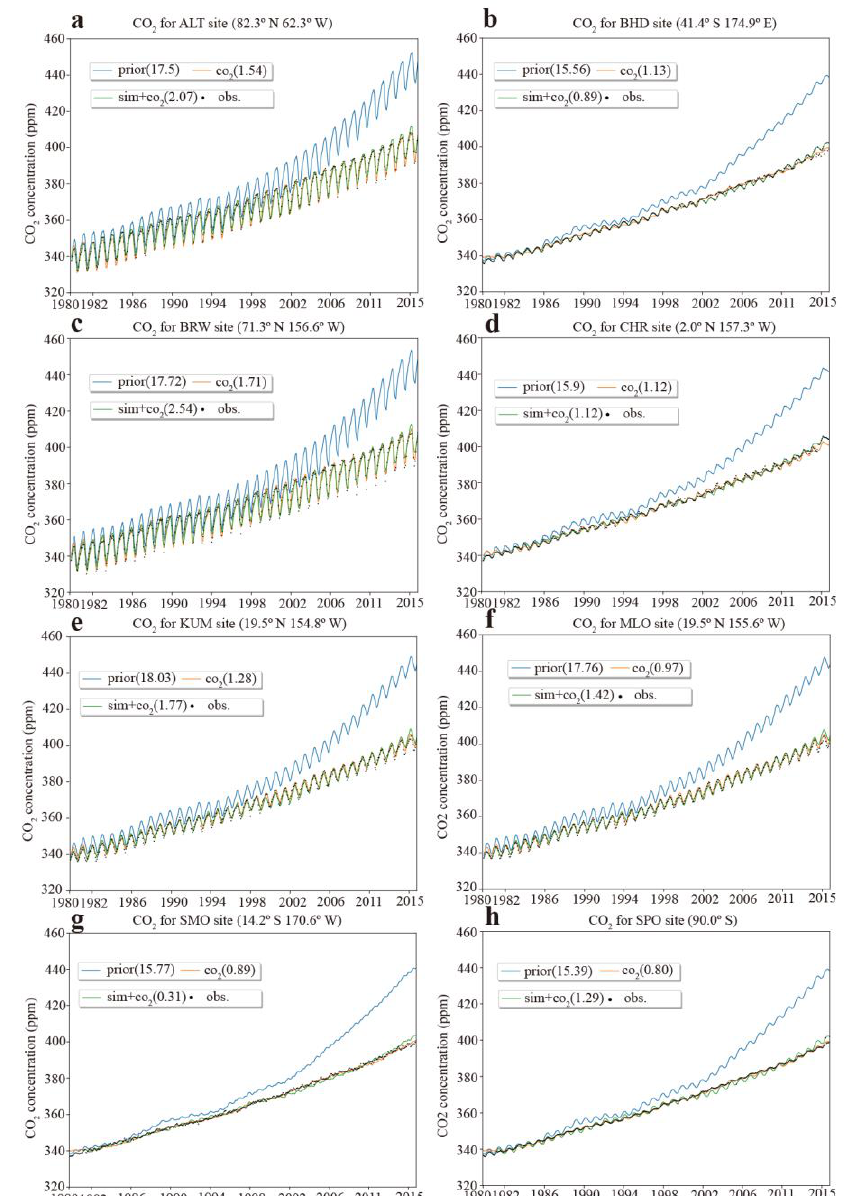
Figure A1. Comparison of prior and optimized output of CO 2 concentrations at eight sites with SIO data. (a) is ALT site, (b) is BHD site, (c) is BRW site, (d) is CHR site, (e) is KUM site, (f) is MLO site, (g) is SMO site, and (h) is SPO site. The “ prior ”, “ co 2 ” , and “ sm + co 2 ” experiments are represented by blue, orange, and green lines, respectively; the SIO observations are represented by black dot. Simulation results and observations are depicted with monthly data, The RMSEs for these three experiments are represented by the values in the legend, in ppm.